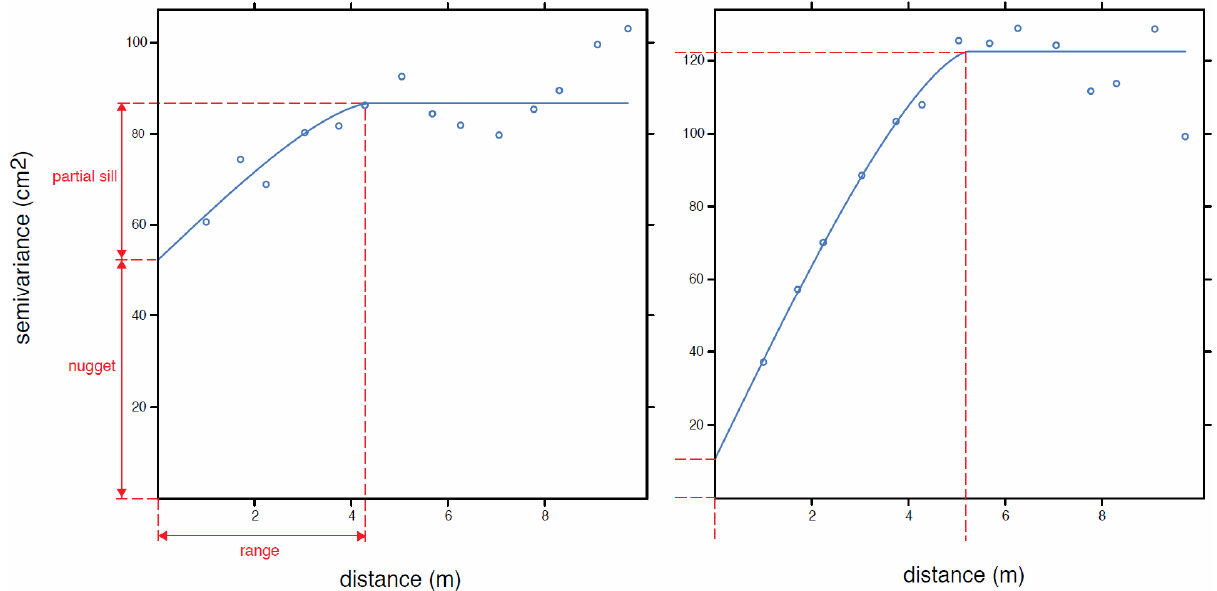
Fig. 1. Illustrates semivariograms of two different empirical semivariogram (dots) and fitted circular semivariogram model (blue line) of two sampling plots in January (left) and April